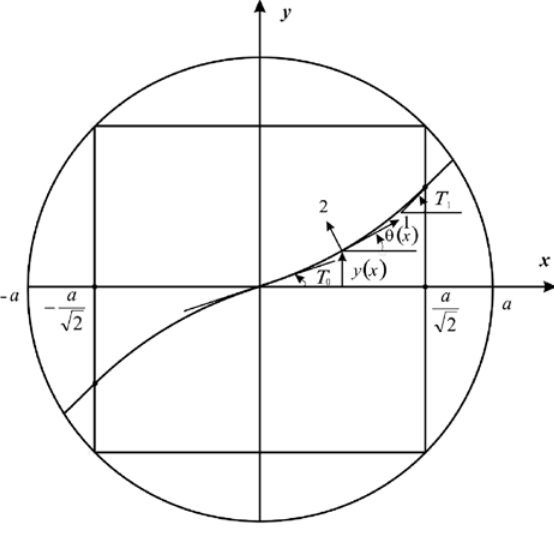
Figure 1: Reference fiber path and